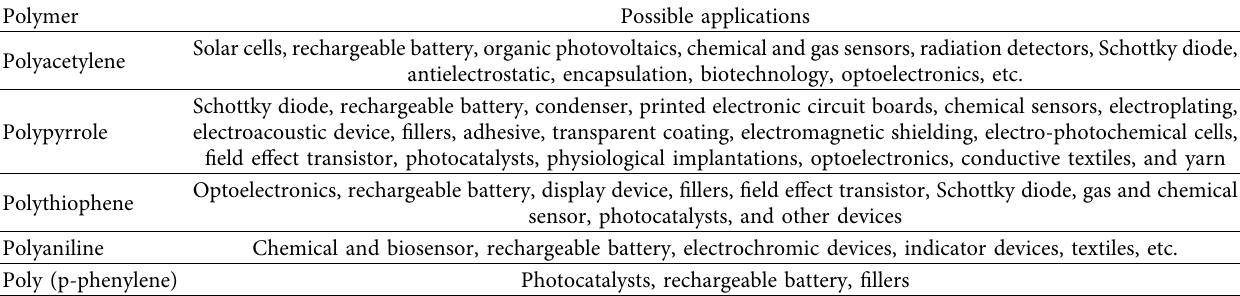
Table 3: Applications for some of the most imperative conducting polymers in energy harvesting.